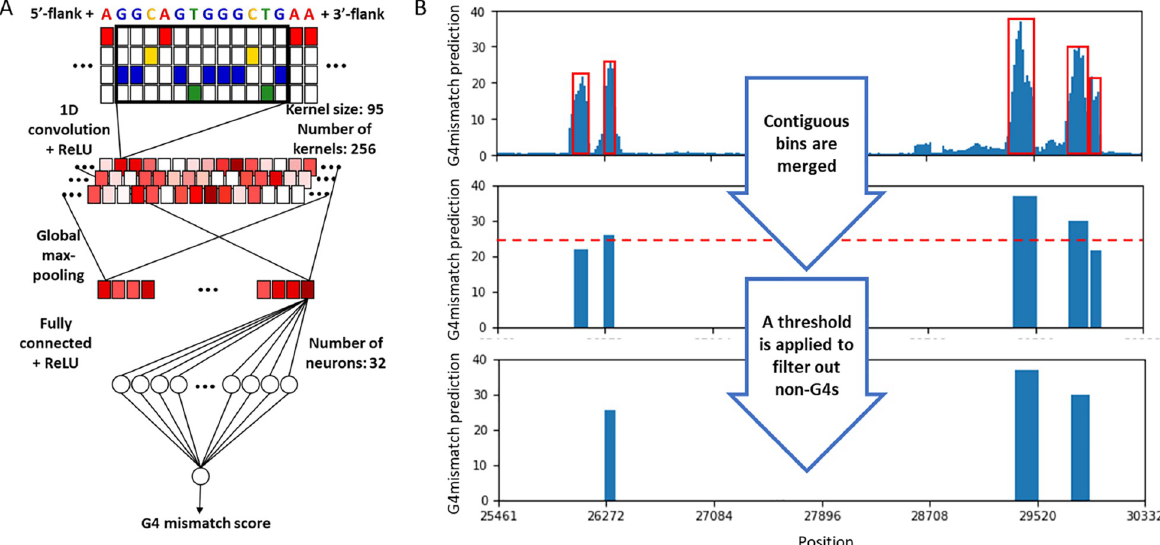
Fig 2. G4mismatch for mismatch score prediction and G4 identification. (A) For mismatch score prediction of a given 15 nt-long sequence, the sequence is padded with 100 nt-long flanks on each side and is one-hot encoded. The one-hot matrix goes through a 1D-convolutional layer with ReLU activation, consisting of 256 kernels of size 95. The output of the convolutional layer goes through a global max-pooling layer and a fully connected layer with 32 neurons. The network output is governed by a single neuron with linear activation. (B) The predicted mismatch scores are used to identify potential G4-forming genomic regions. Contiguous bins with a mismatch score above 14.4 are merged and assigned the maximum mismatch score within the merged area. Sequences with a score smaller than 25 and 35 for K + and K + +PDS experiments, respectively, are filtered out. The resulting sequences are defined as having the potential to form a